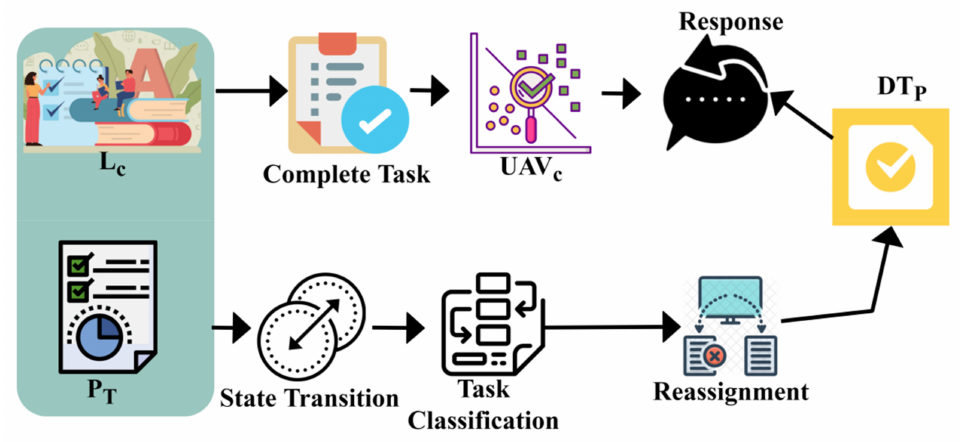
Figure 5. Response-generating